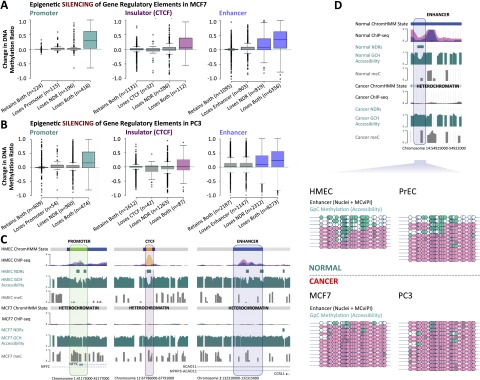
Epigenetic silencing of enhancers and insulators, in addition to promoters, in cancer cells. (A) Promoters (broadly, nucleosome-depleted, and H3K4me3 enriched) were defined in HMEC cells. These exact genomic regions were subject to ChromHMM classification in MCF7 cells and the extent and type of epigenetic silencing (nucleosome acquisition, loss of active epigenetic marks, and gain of DNA methylation) was determined at promoters (left panel, teal). Similarly, insulators (broadly, nucleosome-depleted, and CTCF; center panel, purple) and enhancers (broadly, nucleosome-depleted, and H3K4me1 enriched; right panel, blue) were defined in HMEC cells. These exact genomic regions were subject to ChromHMM classification in MCF7 cells, and the extent and type of epigenetic silencing was determined at insulators and enhancers. (B) As in A, for PrEC and PC3. (C) Screenshots showing epigenetic reprogramming at a promoter (left panel), a CTCF site (middle panel), and an enhancer (right panel). For ChIP-seq tracks: (orange) CTCF; (pink) H3K27ac; (purple) H3K4me1; (green) H3K4me3; and (red) H3K27me3. (D) Validation of enhancer epigenetic silencing. Representative colors for ChIP-seq tracks are as shown in C. All four cell types were treated with M.CviPI GpC methyltransferase and subjected to bisulfite conversion and cloning. Horizontal lines represent individual enhancers. Circles represent GpC dinucleotides: (white) unmethylated and inaccessible to M.CviPI; (teal) methylated and accessible to M.CviPI. Pink bars represent sites associated with nucleosomes. Regions accessible to M.CviPI (teal) indicate NDRs. Diagram is drawn to scale.